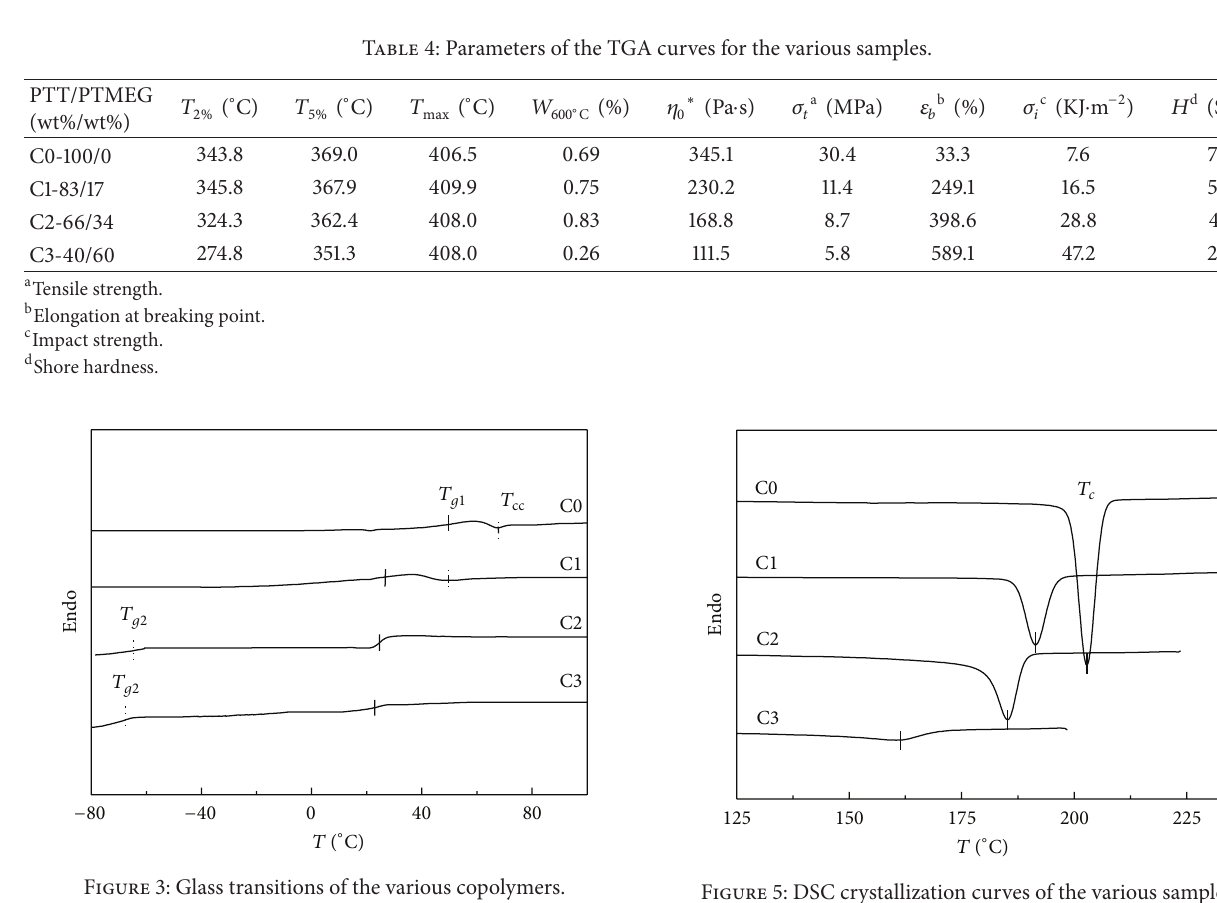
Figure 5: DSC crystallization curves of the various